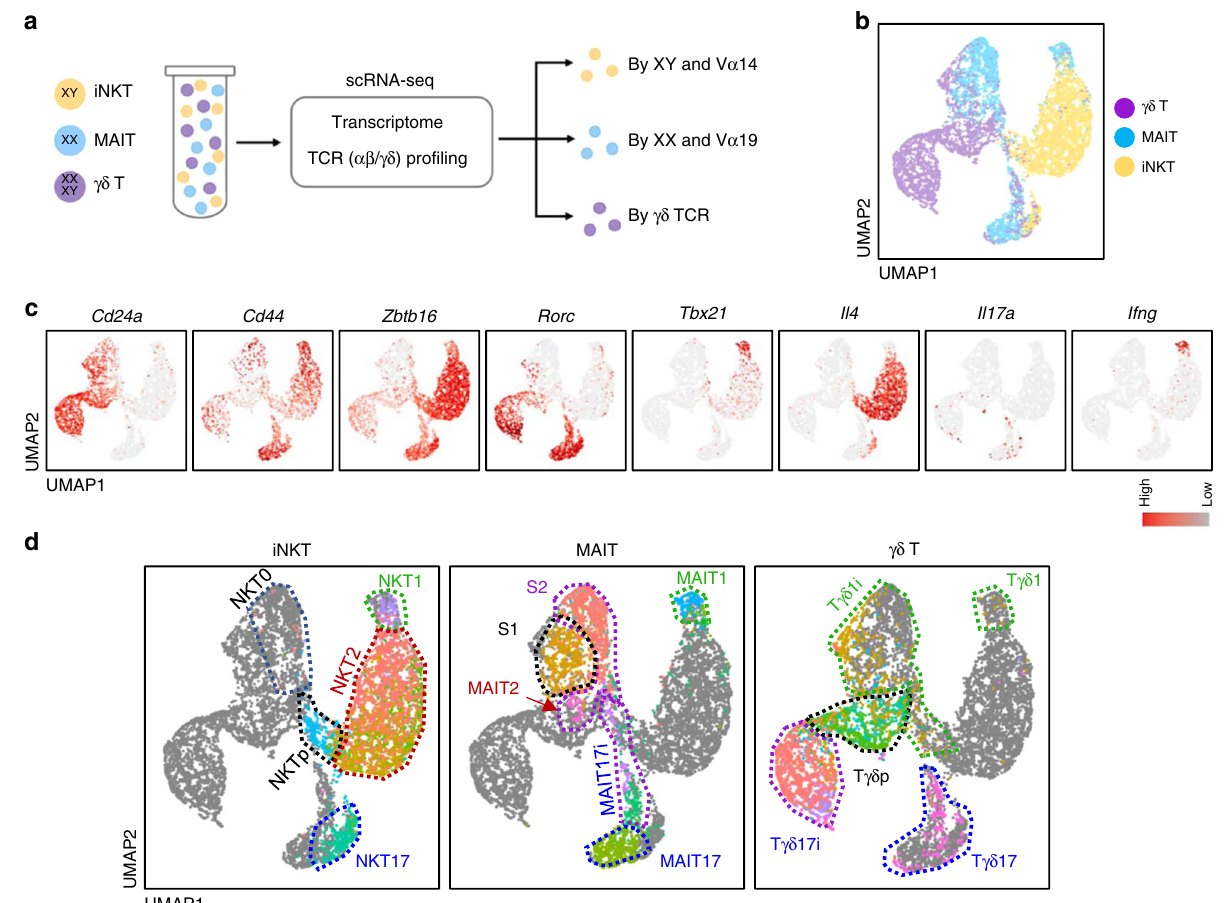
Fig. 2 scRNA-seq de fi nes developmental intermediates of innate T cells. a Experimental scheme of scRNA-seq analysis is shown. b Uniform manifold approximation and projection (UMAP) plot shows all innate T cells (8239 cells) derived from two pooled replicates. Each cell type was labeled with indicated colors. c UMAP plots show the expression levels of indicated marker genes. Colors represent the log 2 -transformed normalized counts of genes. d Combined UMAPs with each type of innate T cell divided into cell clusters (colored): iNKT (3285 cells, left), MAIT (2287 cells, middle), and γδ T cells (2667 cells, right). Cell clusters were annotated as analyzed in Supplementary Figs. 8 –